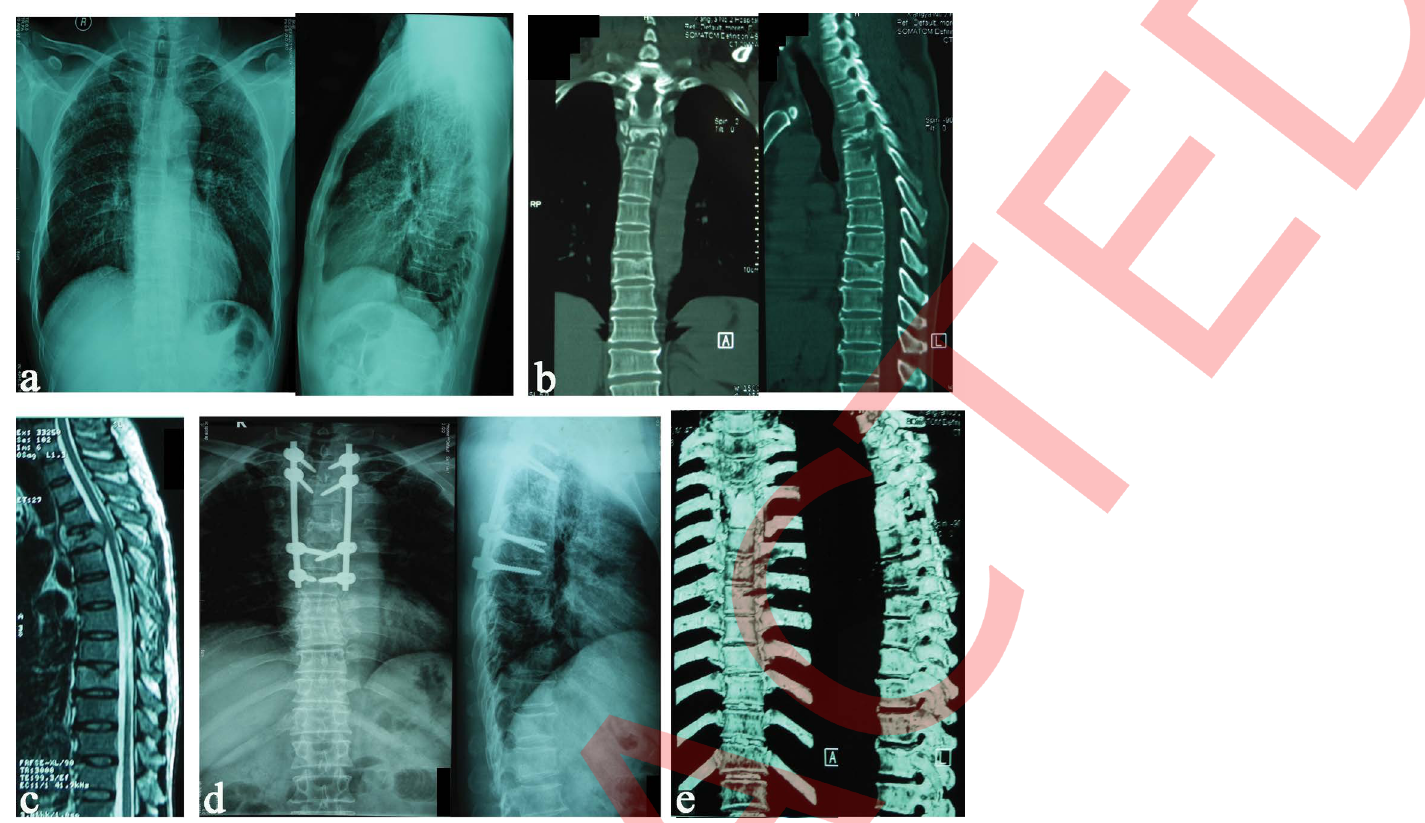
Fig 3. 47-year-old man with T4 – 5 tuberculosis, underwent transforaminal debridement, interbody fusion (iliac bone autograft) and posterior instrumentation. (a) Preoperative X-ray films of thoracic spine show paraspinal shadow (left) and a narrowed disc space at T4 – 5. (b) Coronal and sagital CT scans demonstrate tuberculosis cavities and parevertebral abscess at T4 – 5. (c) T2W sagittal MRI showing enhancements of the inflammatory vertebral bodies and tissue. (d,e) X-ray films and CT of thoracic spine show grafts union at the final follow-up of 42 months.